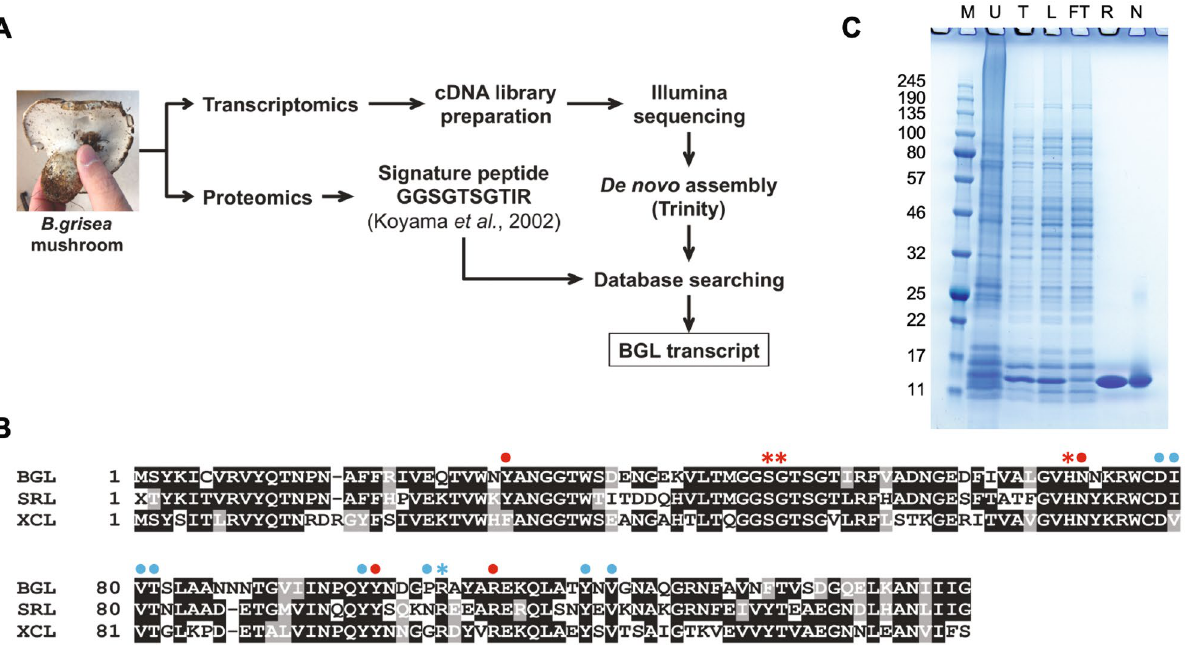
Figure 1. Identification and expression of a BGL transcript. ( A ) A combined transcriptomics and proteomics workflows were used to identify a BGL transcript. Total RNA was isolated and a directional cDNA library was prepared for RNA-Seq. De novo assembly without a reference genome was performed using Trinity software 17 . The signature peptide sequence (GGSGTSGTIR) was previously generated by CNBr and N-terminal sequencing 9 . BLASTX using GGSGTSGTIR as the query was used to probe the assembled B. grisea transcriptome to identify a full-length BGL transcript. ( B ) The deduced peptide sequence of BGL (143 a.a.) was aligned with those of S. rolfsii lectin (SRL) and X. chrysenteron lectin (XCL) using T-Coffee 39 and BoxShade 40 . Identical residues are shaded black, and similar residues are shaded gray. Amino acids that comprise the primary and secondary ligand binding sites of SRL are shown with red or blue symbols (dots and asterisks), respectively (see also Supplement Fig. S4). Four amino acids (asterisks) were individually mutated to disrupt binding in the respective pockets. ( C ) E. coli -expressed and purified recombinant BGL was visualized by separation via